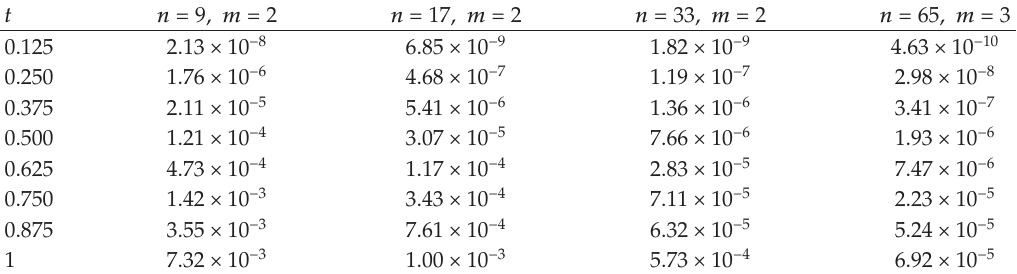
Table 1: Numerical results for Example 4.1.